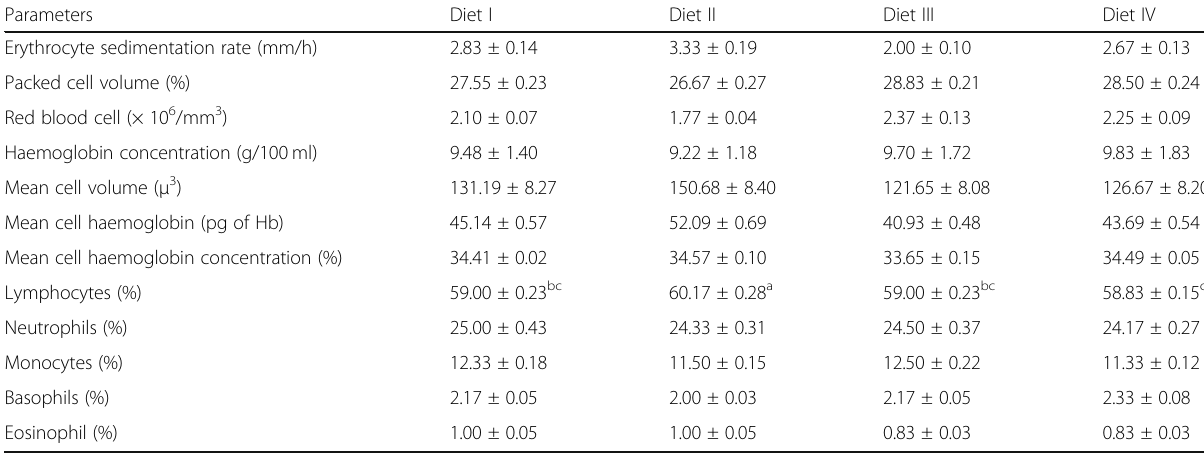
Table 7 Haematological parameters of broiler chickens fed with diets containing fortified bread waste meals